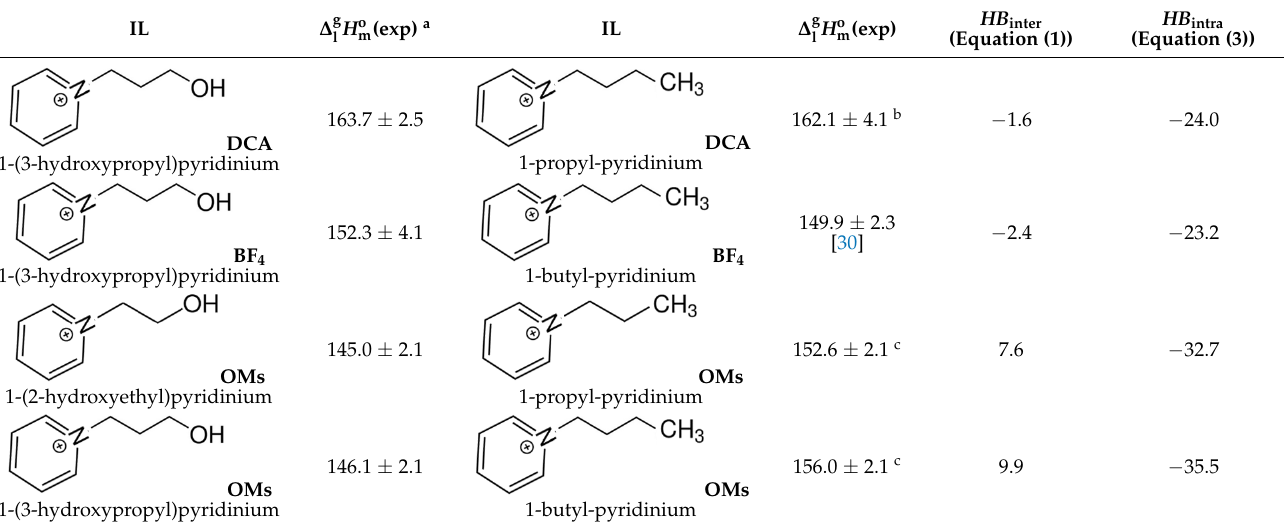
Table 6. Experimental enthalpies of vaporisation of hydroxyl-alkyl-pyridinium and alkyl-pyri- dinium ionic liquids containing [DCA], [BF 4 ], and [OMs] anions and the strength of inter- and intra- HB calculated from these values (at 298 K, in kJ mol −1 ).